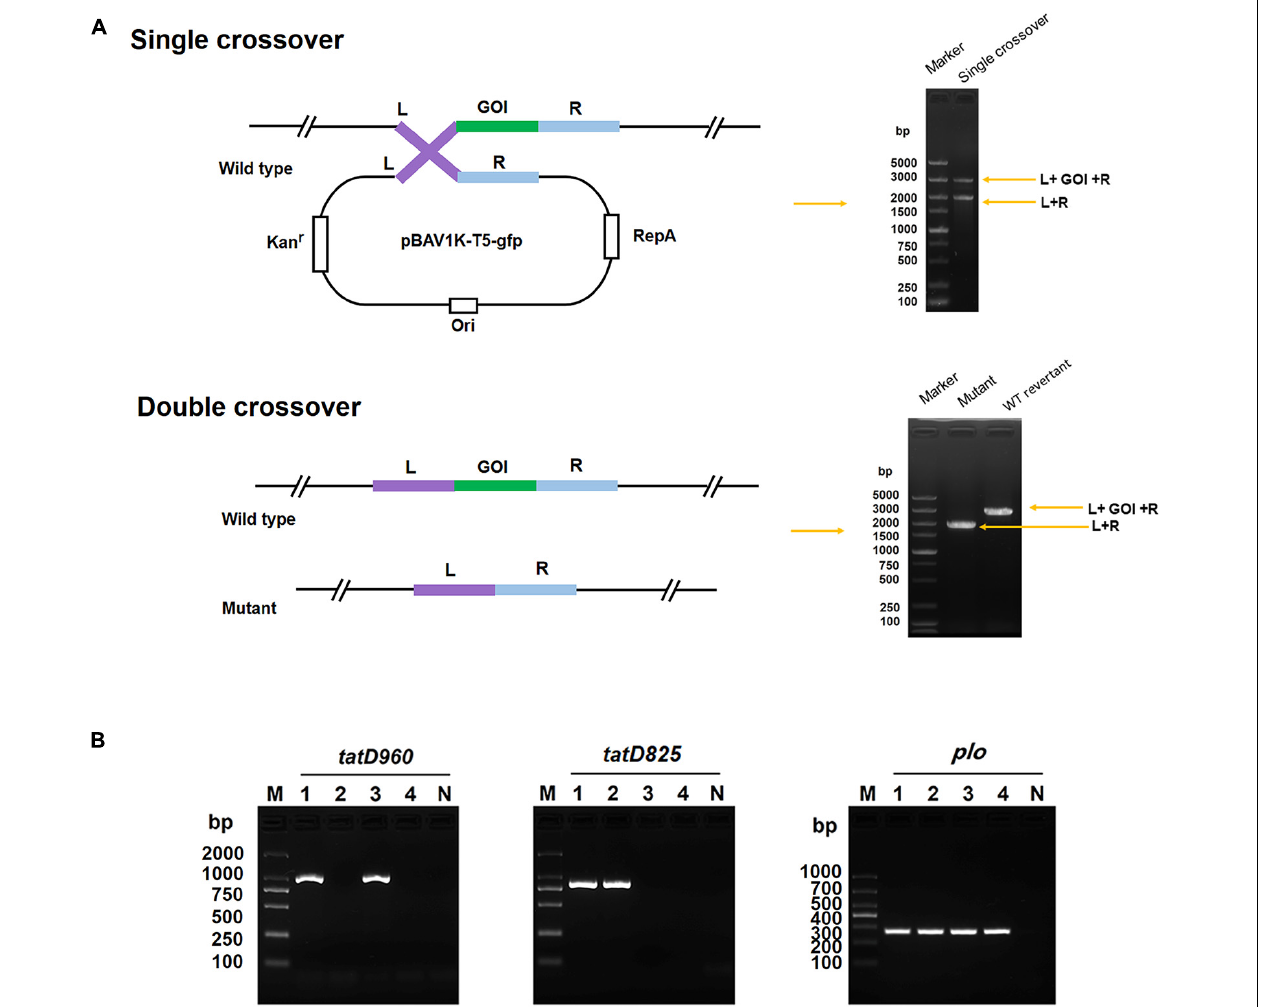
FIGURE 1 | Construction of the tatD -deficient mutants in T. pyogenes strain BMH06-3 based on the plasmid PBAV1K-T5-gfp. (A) Illustration of markerless knockout construction in T. pyogenes . Kan, kanamycin; L, upstream homologous arm; R, downstream homologous arm; GOI, gene of interest; and WT, wild-type. (B) Identification of tatD -deficient strains using PCR and sequencing. The mutants were identified by PCR using three primer pairs: tatD960 F/R, tatD825 F/R, and plo F/R. Lane 1, BMH06-3; Lane 2, BMH06-3 (cid:49) tatD960 ; Lane 3, BMH06-3 (cid:49) tatD825 ; Lane 4, BMH06-3 (cid:49) tatD960 (cid:49) tatD825 . M, DNA Marker